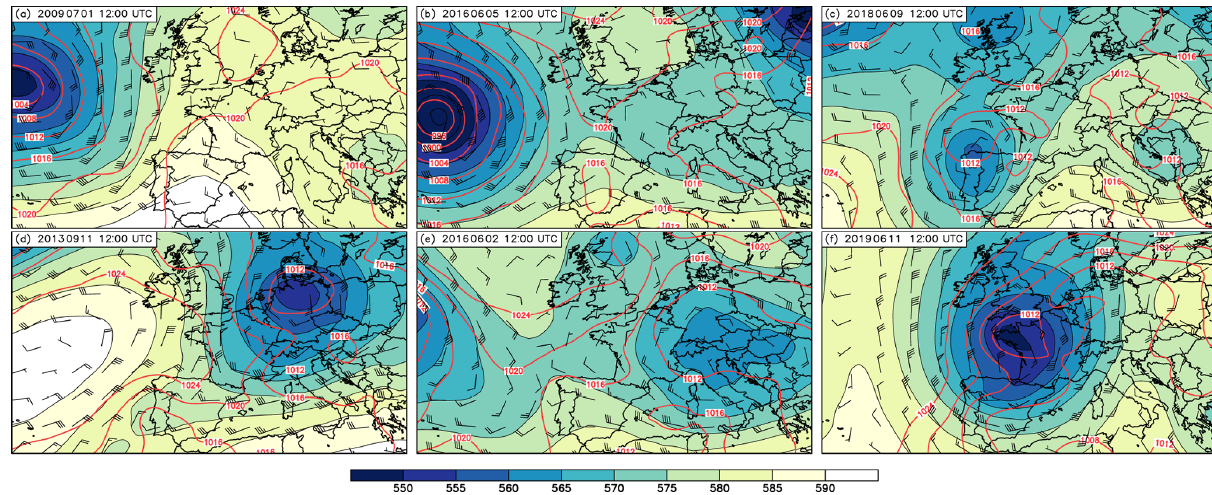
Figure 3. Global Forecast System (GFS) analyses at 12:00UTC for the cases with weak (a–c) and strong (d–f) synoptic-scale forcing showing 500hPa geopotential height (gpdm; shading), sea level pressure (hPa, red contours), and 500hPa wind barbs.